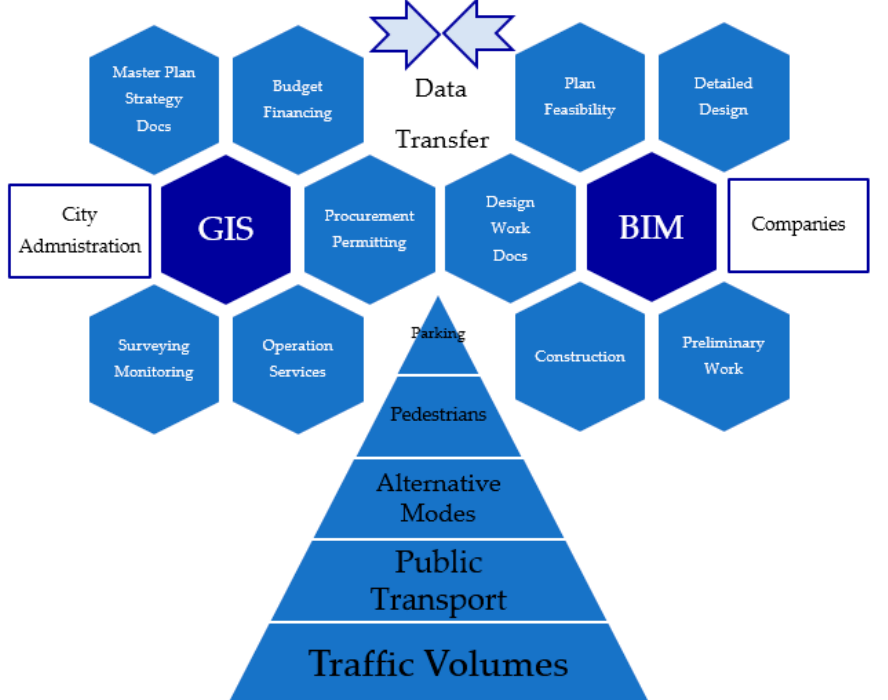
Figure 2. Processes of spatial planning involving traffic.